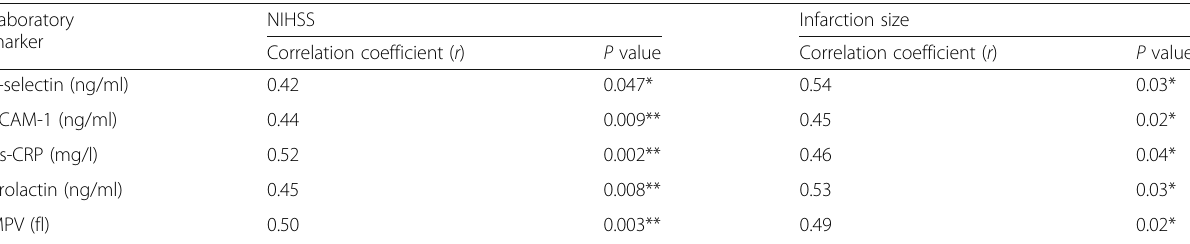
Table 7 Correlation between INHSS score, infarction size, and levels of laboratory markers on admission Laboratory marker